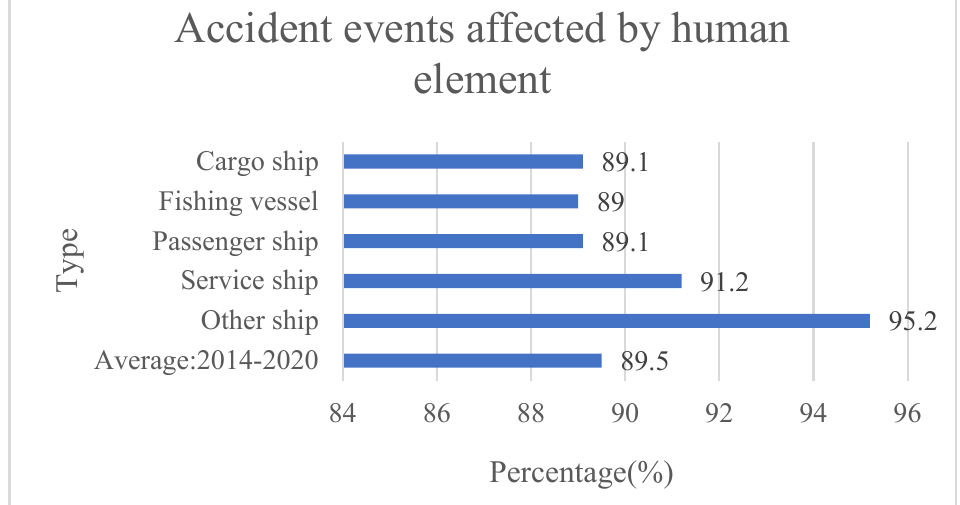
Figure 1. Accident events affected by human element.